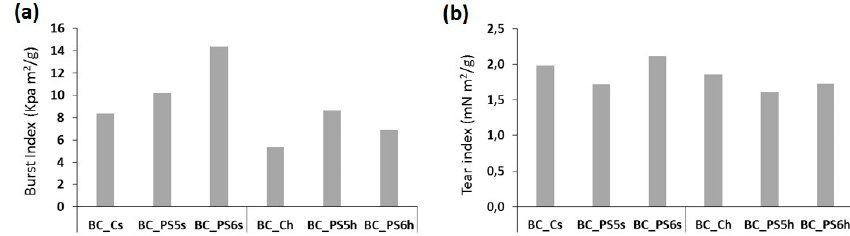
Figure 6. ( a ) Burst index (KPa m 2 /g) and ( b ) tear index (mN m 2 /g) of the samples.